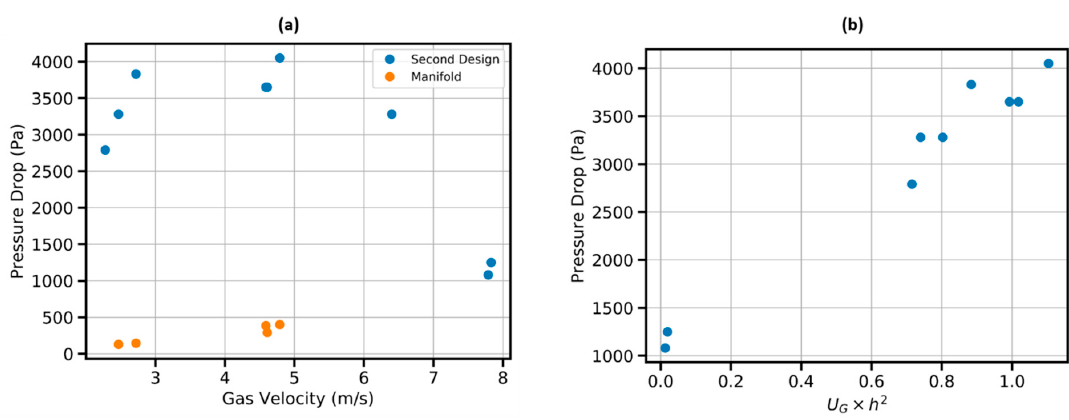
Figure 13. Pressure drop between the inlet (P 1 ) and P 4 against ( a ) the gas velocity at the inlet, and ( b ) the product of the gas velocity and square of the maximum liquid height at the swan neck. The results are averaged over a period of 5 s.